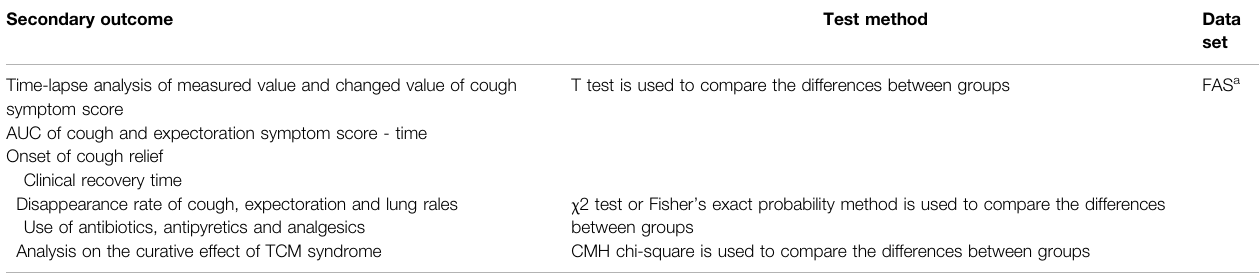
TABLE 5 | Secondary